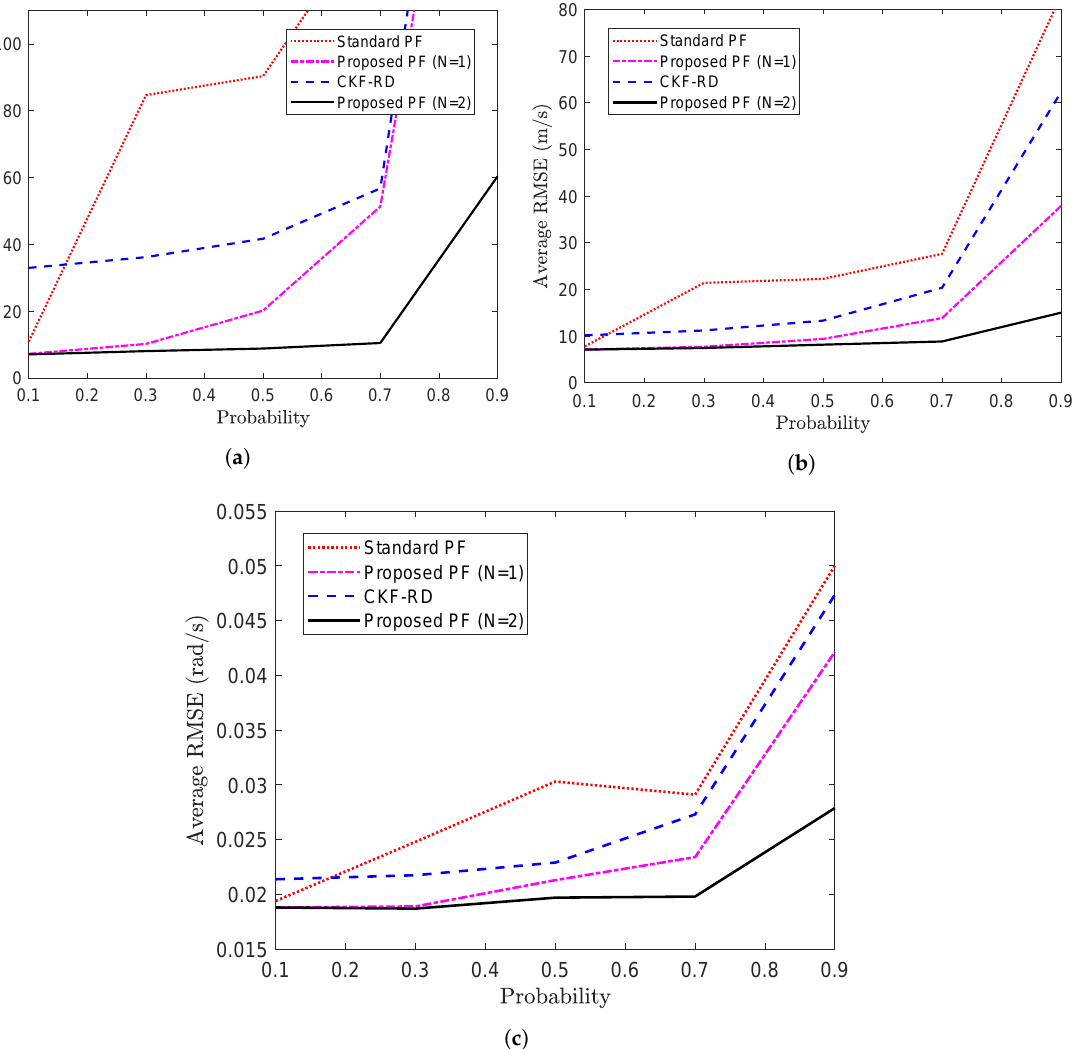
Figure 12. Average RMSE vs. probability ( a ) Average RMSE of position ( b ) Average RMSE of velocity ( c ) Average RMSE of turn rate (Problem